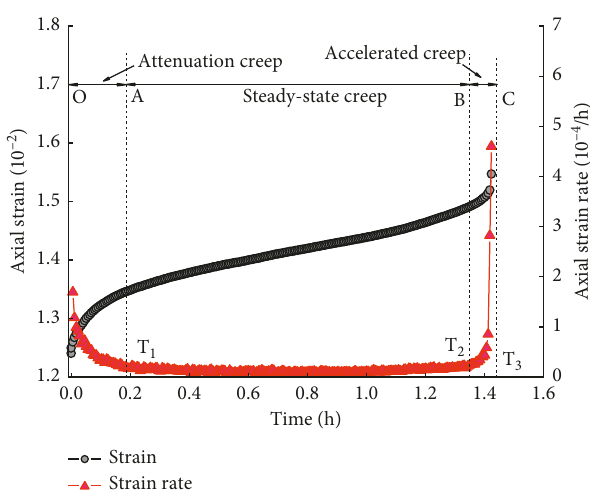
Figure 11: Creep-strain rate versus time (specimen S4, 20 ° C).